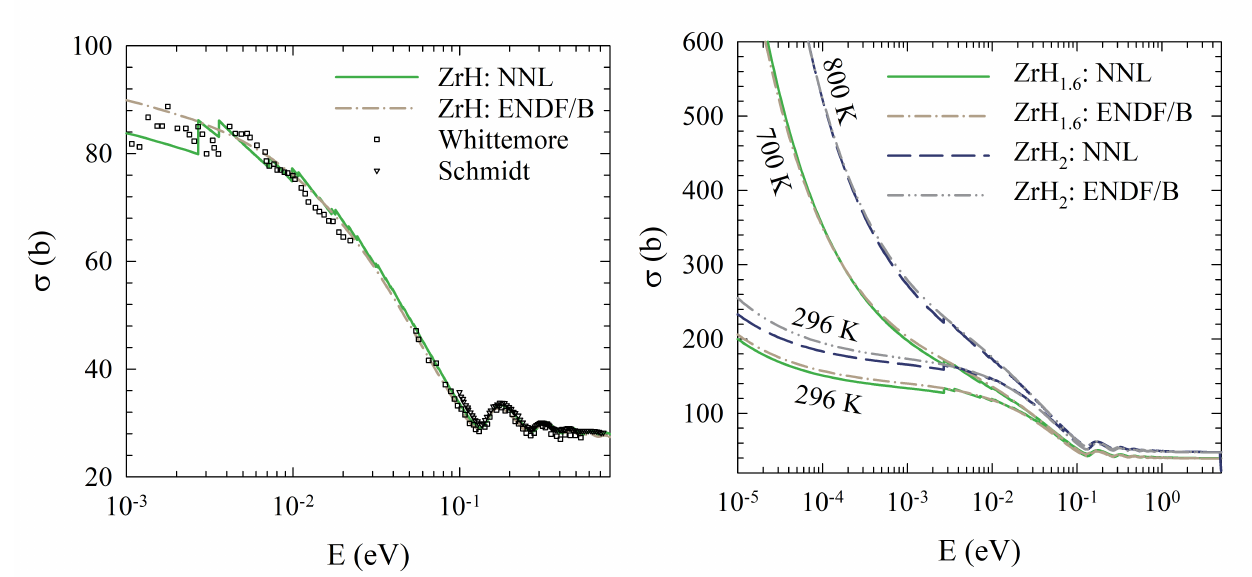
Figure 4. Scattering cross section of δ -ZrH compared to experiments at room temperature, Whittemore [6] and Schmidt [33] ( left ). Scattering cross sections of δ -ZrH 1.6 and (cid:101) -ZrH 2 compared to current ENDF/B-VIII.0 evaluations ( right ). The inte- grated cross section for both the NNL TSL evaluation and ENDF/B-VIII.0 were generated with the NDEX nuclear data processing code